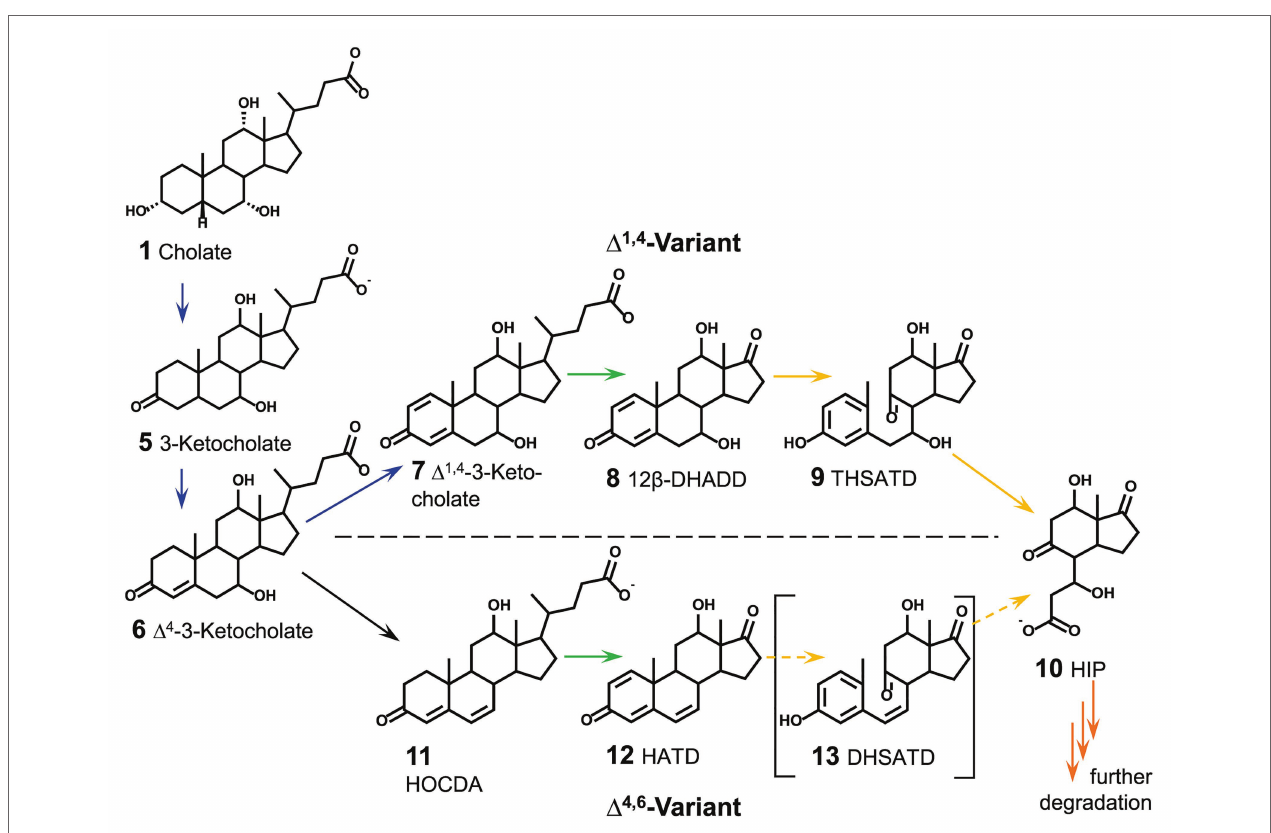
FIGURE 2 | Section of aerobic steroid degradation of model substrate cholate via the Δ 1,4 -variant and Δ 4,6 -variant of the 9,10- seco -pathway as found in Pseudomonas stutzeri Chol1 and Sphingobium sp. strain Chol11, respectively. Continuous arrows indicate known reactions, dashed arrows indicate predicted reactions due to bioinformatic analyses, but not experimentally verified. Colors of arrows indicate section of steroid degradation: blue A-ring oxidation, green side-chain degradation, yellow B-ring cleavage and degradation of rings A and B, orange degradation of rings C and D. 12 β -DHADD, 7 α ,12 β -dihydroxy-androsta- 1,4-diene-3,17-dione; THSATD, 3,7,12-trihydroxy-9,10- seco -androsta-1,3,5-triene-9,17-dione; 3 α OH-HIP, 3a α -OH-4a(30-propanoate)-7a β -methylhexahydro-1- indanone; HOCDA, 12-hydroxy-3-oxo-chola-4,6-dienoate; HATD, 12 β -hydroxy-androsta-1,4,6-triene-3,17-dione; DHSATD, 3,12-dihydroxy-9,10- seco -androsta-